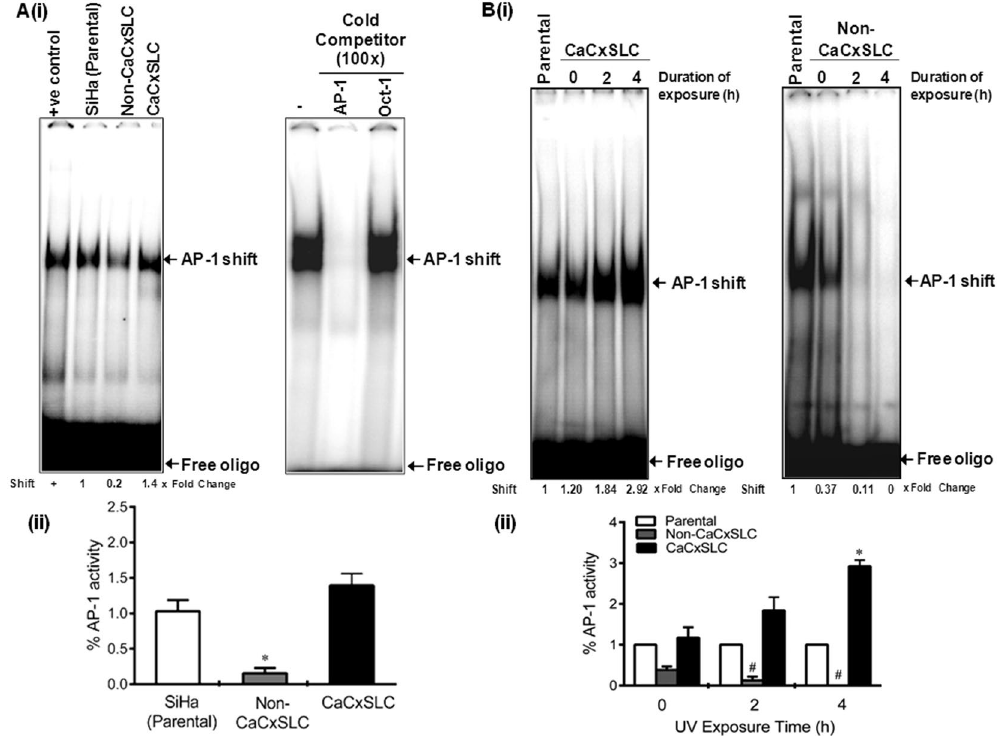
Figure 2. Effect of UVC-treatment on endogenous AP-1 activity and cervicosphere formation in CaCxSLC. ( A ) Status of AP-1 signaling in CaCxSLCs derived from SiHa cells. Representative autoradiogram showing AP-1 specific DNA-binding activity in cells from parental, cervicospheres derived CaCxSLCs and non-CaCxSLCs. Nuclear protein (10 µ g/lane) from CaCxSLC cells (DCM) or non-CaCxSLCs cells (CM) were co-incubated with radiolabelled ( γ - 32 P-ATP) AP-1 consensus sequence that contain AP-1 binding sequence and AP-1 specific DNA-binding was examined (i). AP-1 specific DNA-binding activity was verified by cold competition as described in Method by co-incubating 100x molar excess of either unlabelled homologous AP-1 probe or heterologous Oct-1 probe (ii). Numbers on the bottom represent fold change in AP-1 binding vs. parental cells. Data are expressed as the mean ± SD of three independent experiments (iii). * p-value < 0.05 vs. untreated controls i.e. CaCxSLCs and non-CaCxSLC cells. Untreated parental SiHa cells were included as positive control. ( B ) Effect of UV on AP-1 DNA-binding activity. Representative autoradiogram showing AP-1 DNA-binding in nuclear proteins (10 µ g/lane) derived from cells of indicated culture that were exposed to 100 J/m 2 UV radiation for variable time interval and harvested after 12 h after completion of the treatment (i). Cumulative quantitative densitometry data of three independent experiments (ii). * p- value < 0.05 vs. untreated cervicospheres of CaCxSLCs, # p-value < 0.05 vs untreated